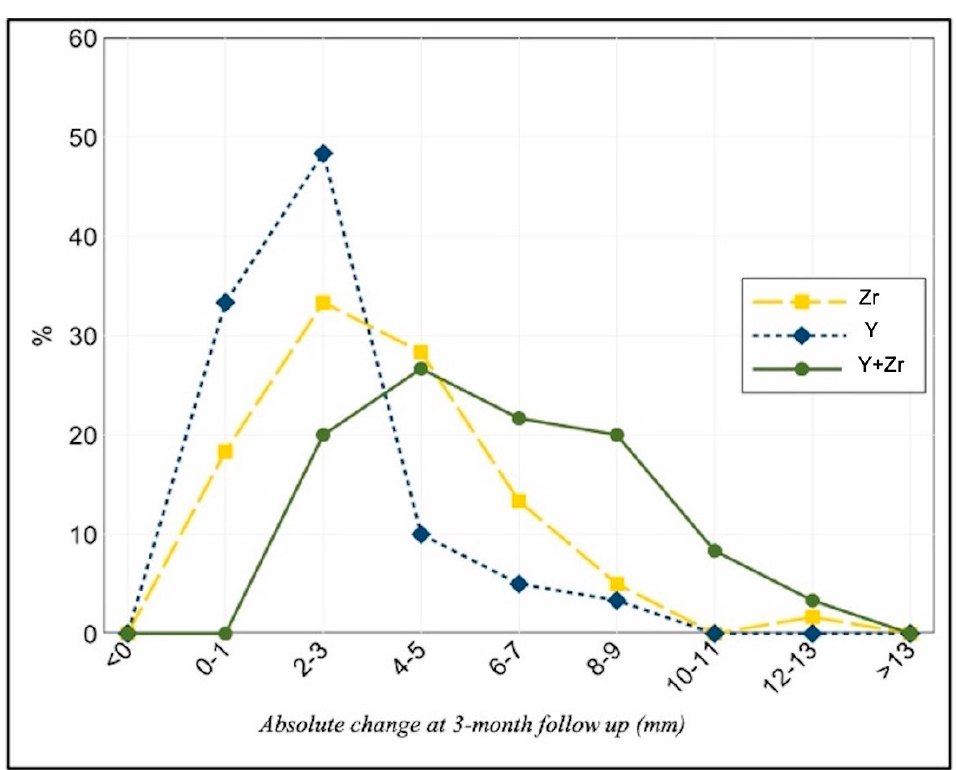
Figure 4. Distribution of absolute changes in Zr, Y and (Y + Zr) at three-month follow-up ( n = 60). At the three months follow-up, Zr exceeded 50% of Y in forty-three patients (72%) who underwent a second step of metroplasty in the early follicular phase of the following menstrual cycle, because Y + Zr was greater than 1 cm, allowing the possibility of a further correction without substantially reducing the thickness of the fundal myometrial wall. Conversely, an optimal removal of the intrauterine septum was confirmed in seventeen patients (28%). As shown in Figure 5, at the three months ultrasound follow-up, the absolute change in (Y + Zr) was positively correlated with the Z and (Y + Z) values before